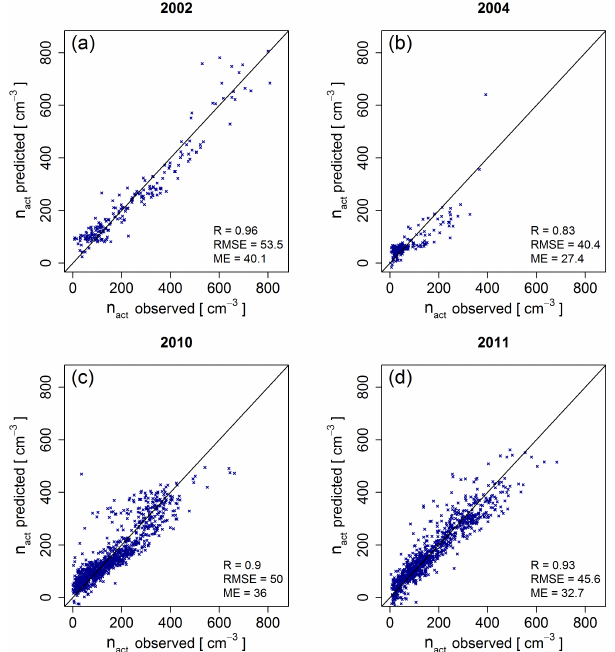
Figure 12. As for Fig. 10, but the model was re-calculated to pro- vide the best fit for each year individually.